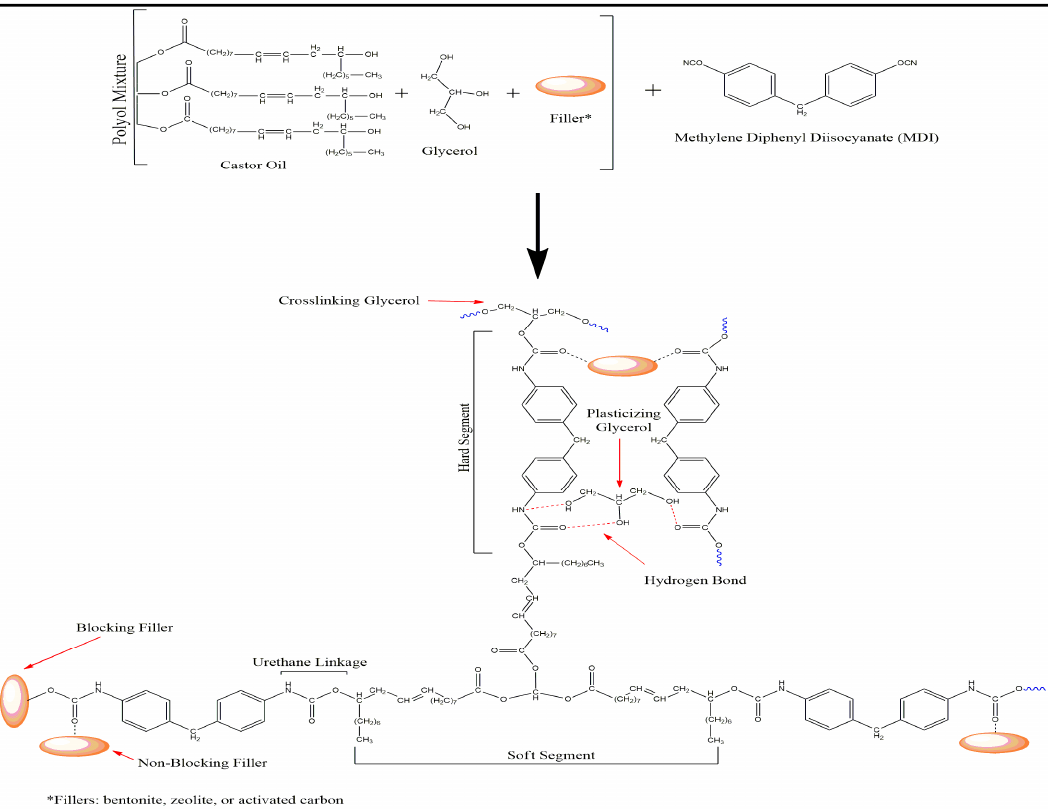
Figure 1. The reaction of castor oil-based PUF via the one-shoot method with the addition of glycerol and fillers.